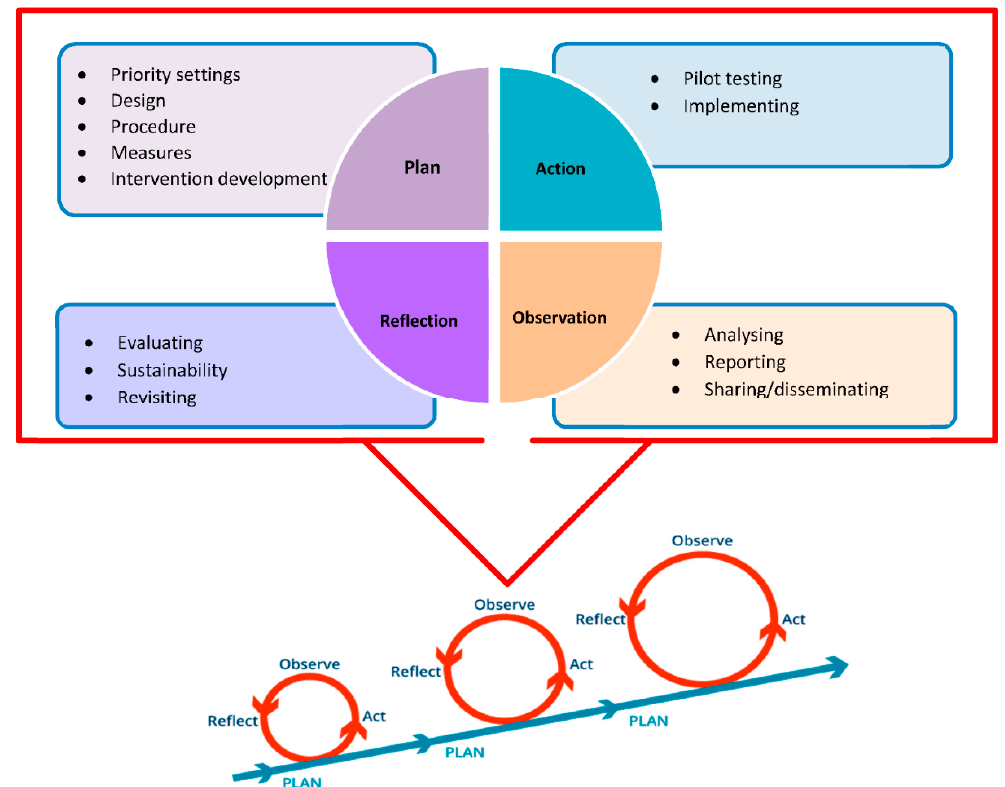
Figure 1. Steps for participatory action research framework.